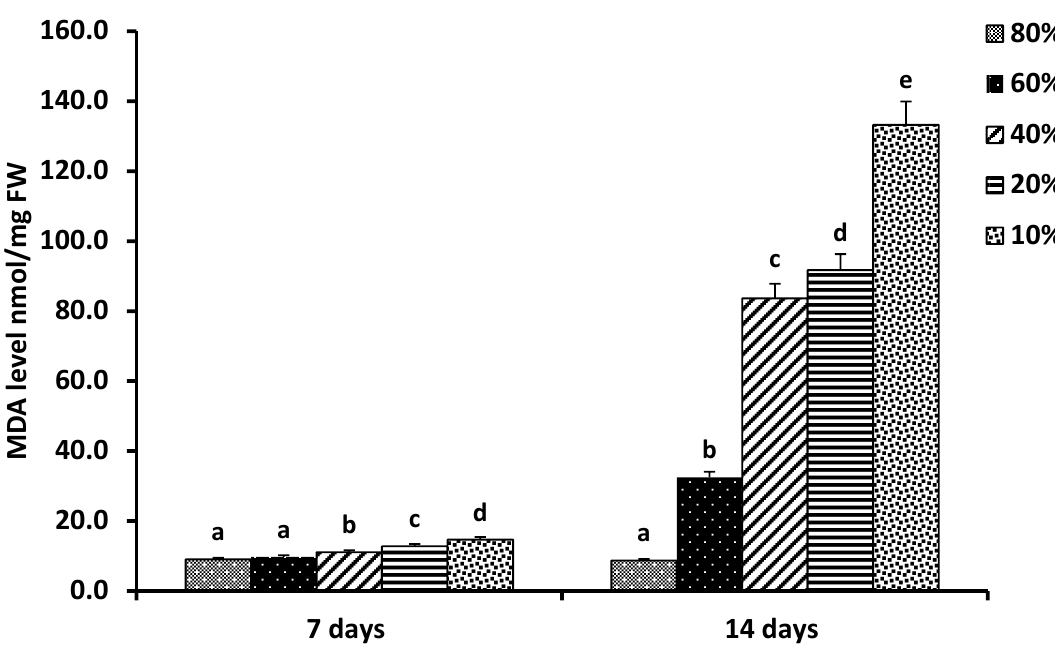
Figure 3. Malondialdehyde (MDA) level of pea ( Pisum sativum L.) seedlings in response to soil water holding capacity levels: 80%, 60%, 40%, 20%, and 10% grown under continuous light at 25 ◦ C for 7 days and 14 days, separately. The MDA level was calculated as nmol/mg FW. Means (columns) with different letter scripts are significantly different ( p ≤ 0.05) by